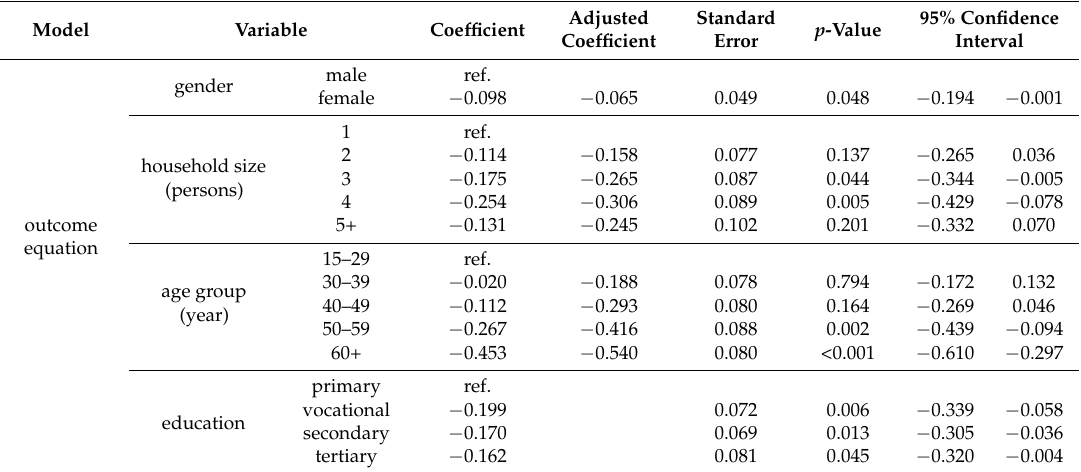
Table 3. Impact of farming on physical activity—estimates of Heckman selection model.